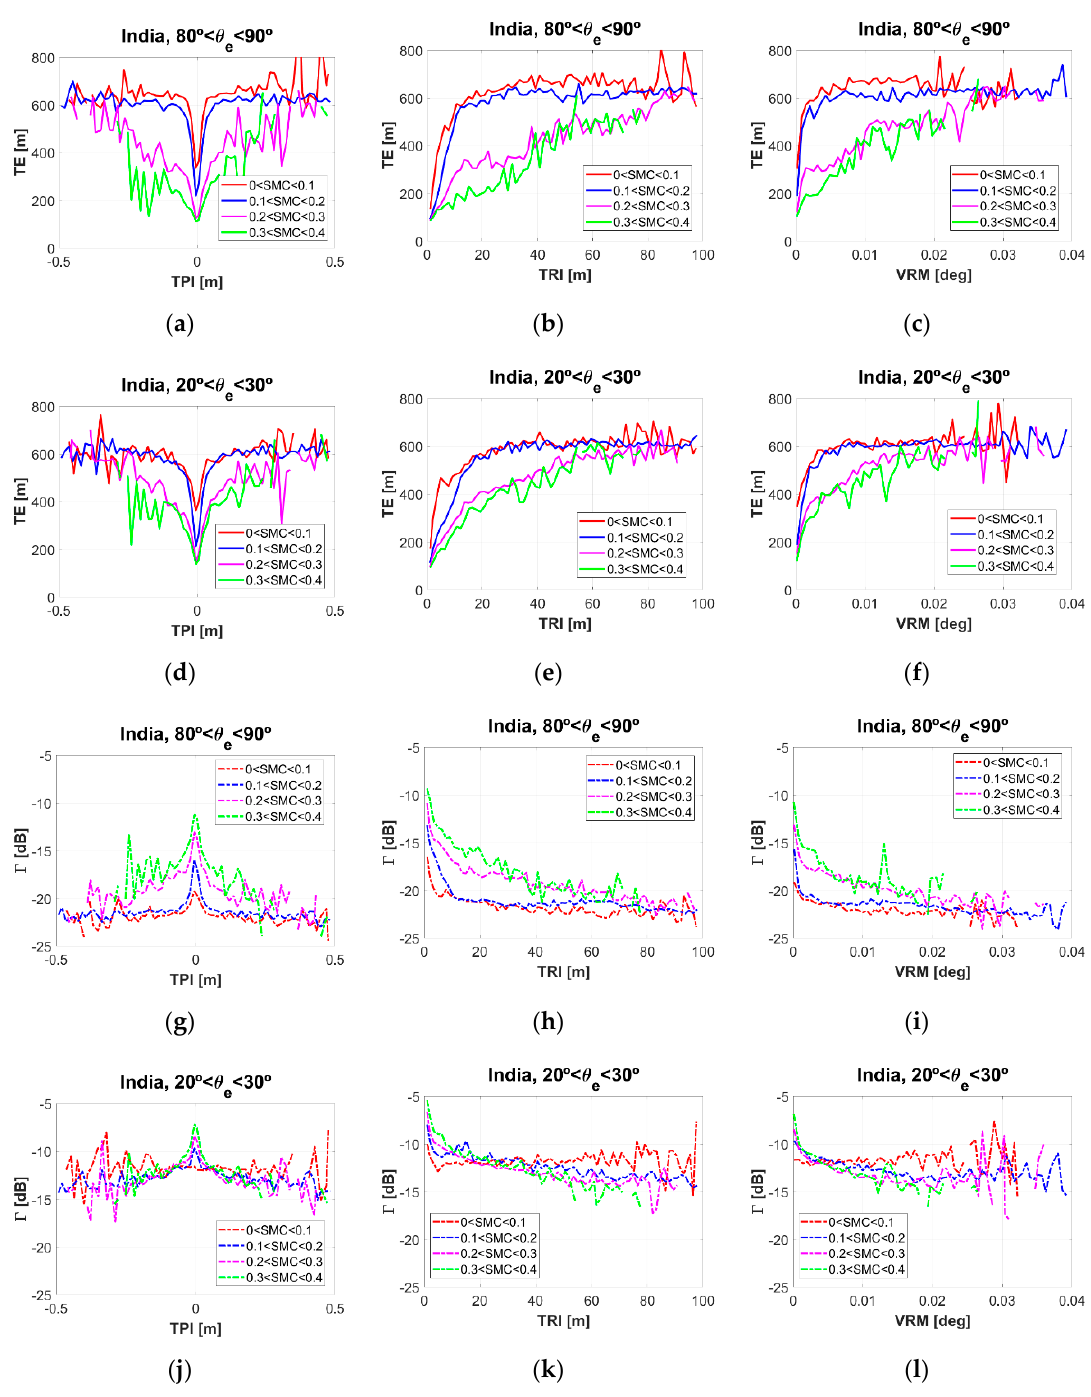
Figure 5. Parametric evaluation as a function of SMAP-derived SMC: ( a , d , g , j ) TPI, ( b , e , h , k ) TRI, and ( c , f , i , l ) VRM. Analysis of CyGNSS-derived TE at θ e ~ [80, 90] ◦ ( a – c ) and θ e ~ [20, 30] ◦ ( d – f ). Analysis of CyGNSS-derived Γ at θ e ~ [80, 90] ◦ ( g – i ) and θ e ~ [20, 30] ◦ ( j – l